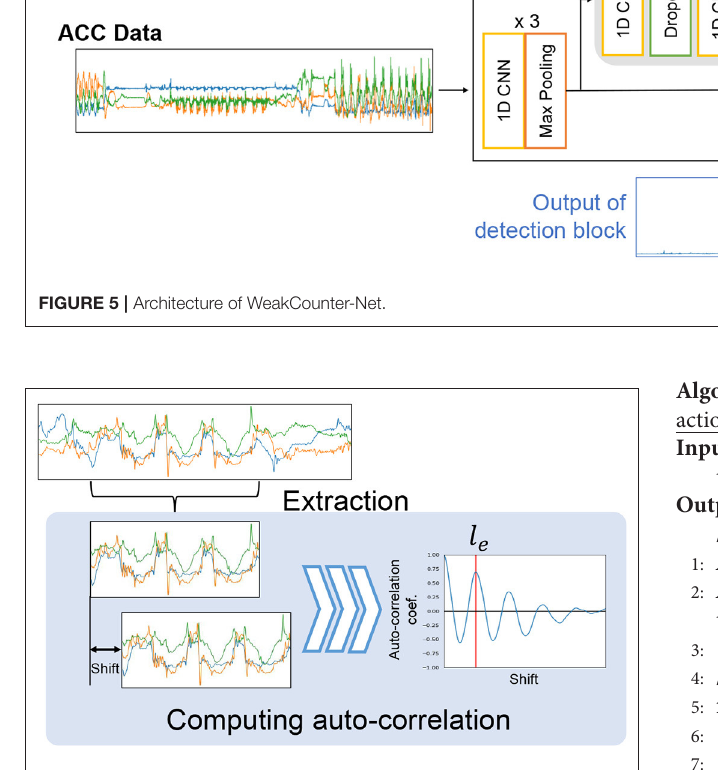
FIGURE 6 | Determining the length of the target action using auto-correlation.